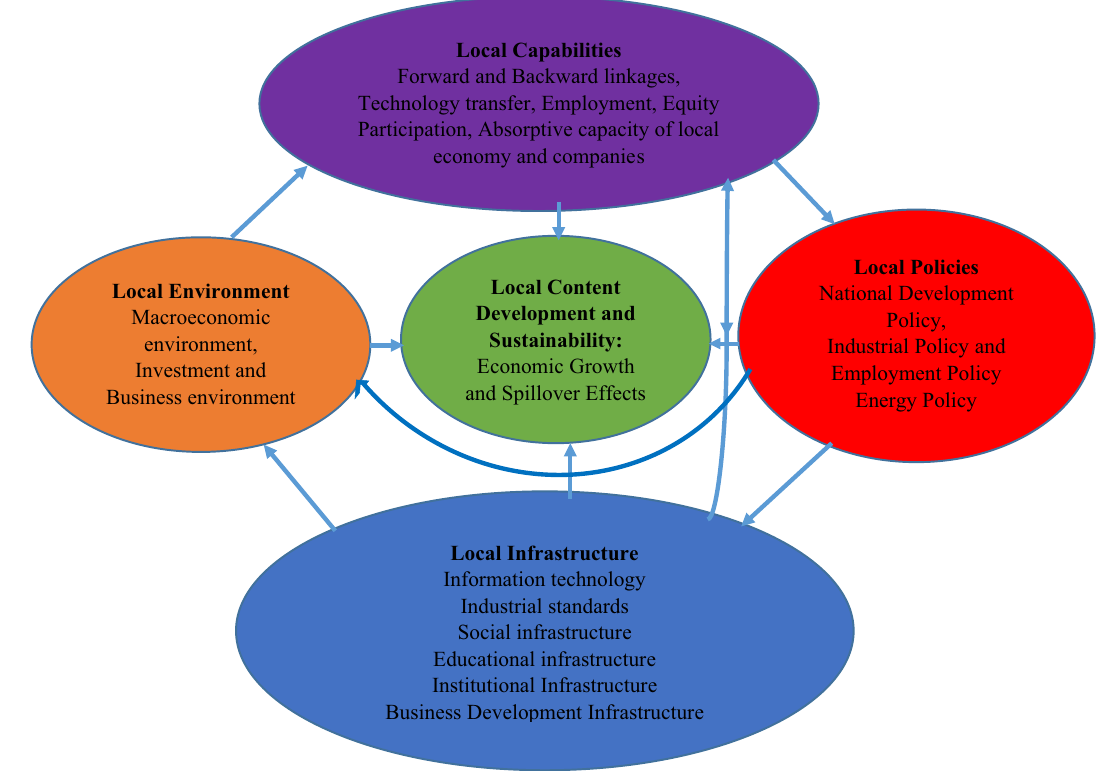
Fig. 1 Conceptual model for local content development in Ghana (Adapted from